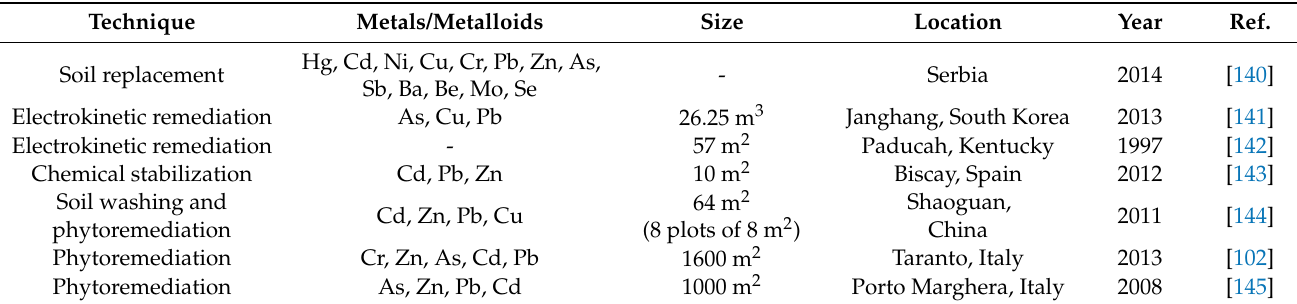
Table 5. Case studies for heavy